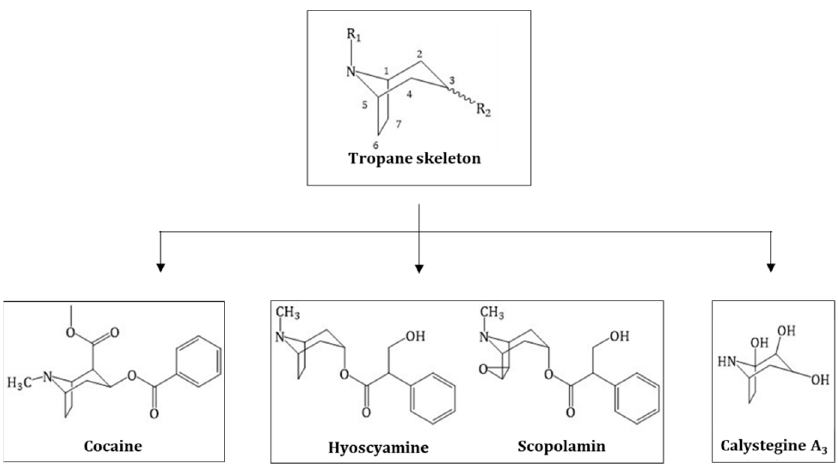
Figure 1. Structure of the tropane skeleton (green box) and the three major groups of TAs derived from this skeleton.